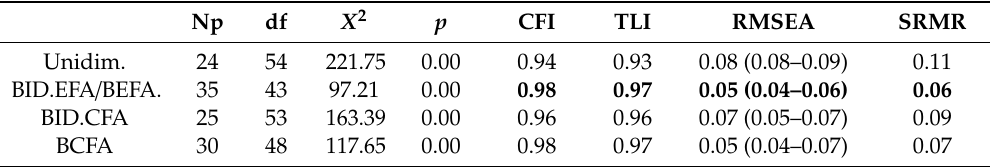
Table A5. Model fit indices for all tested